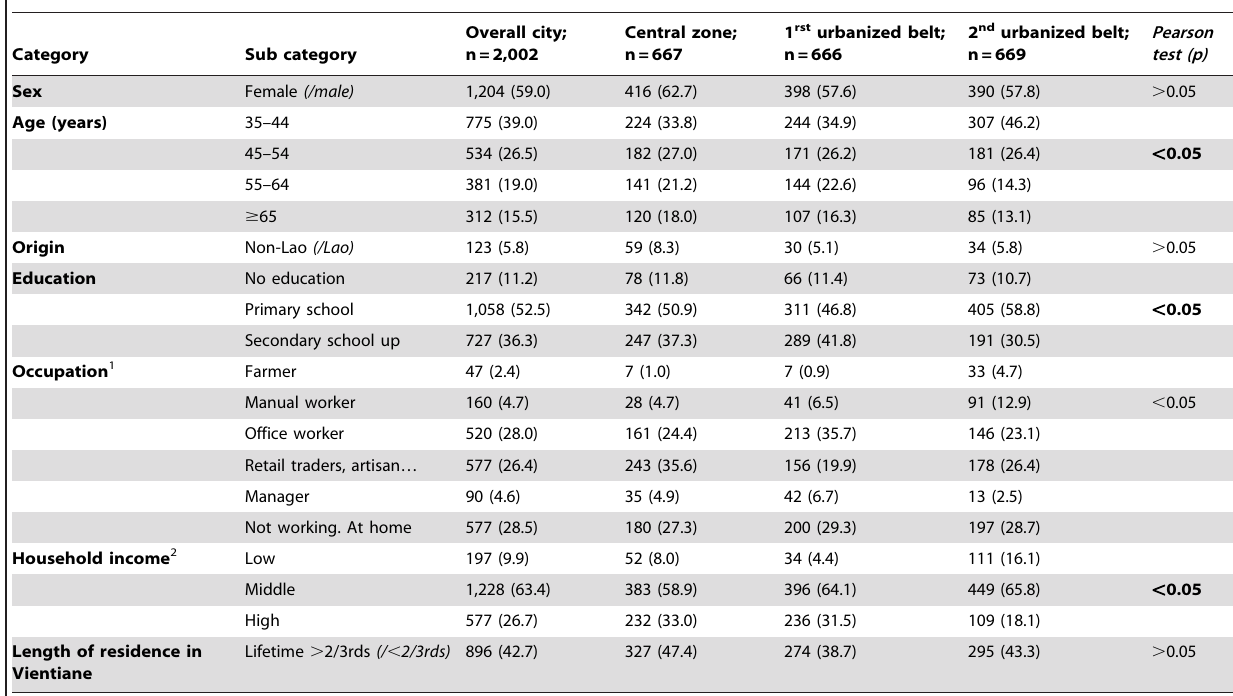
Table 1. Surveyed population of Vientiane city according to their place of residence.